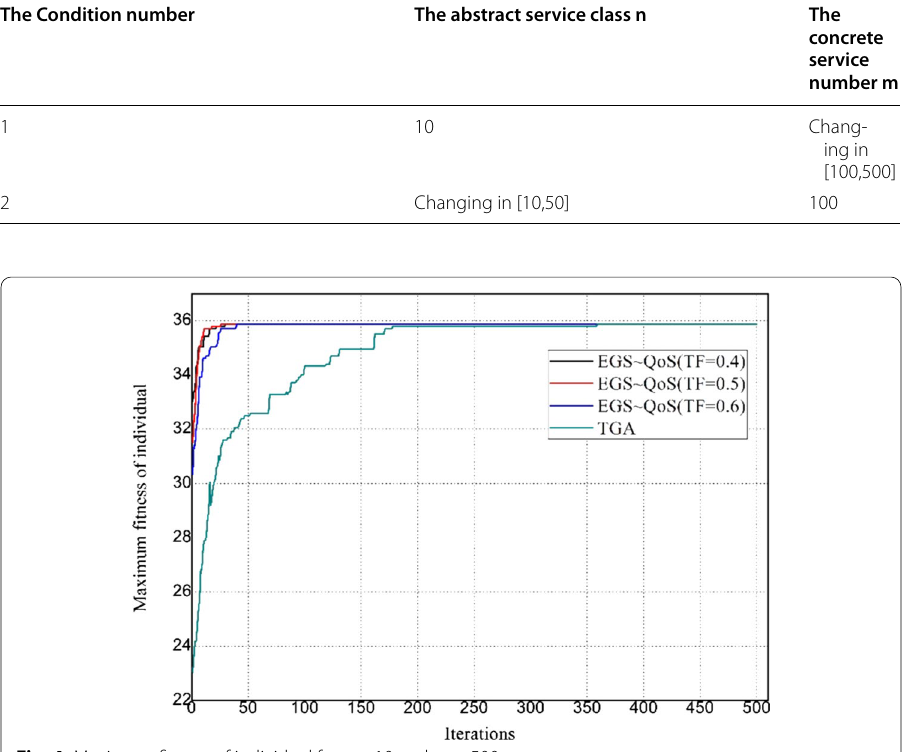
Fig. 4 Maximum fitness of individual for n